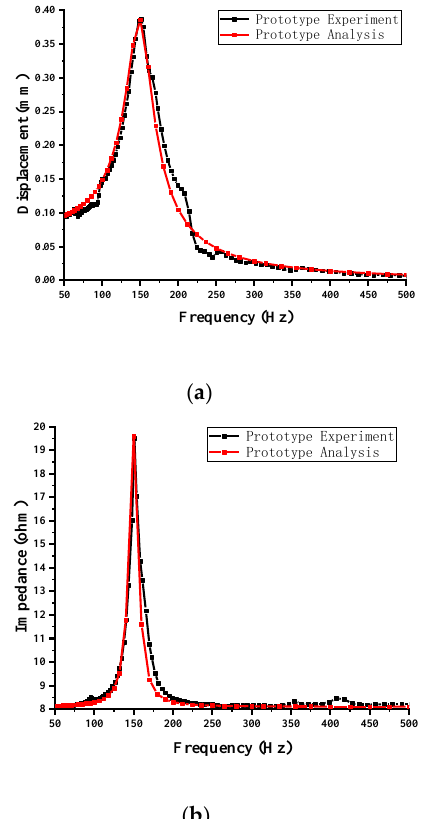
Figure 6. Comparison between experiment and analysis results of the prototype: ( a ) displacement; ( b ) impedance.